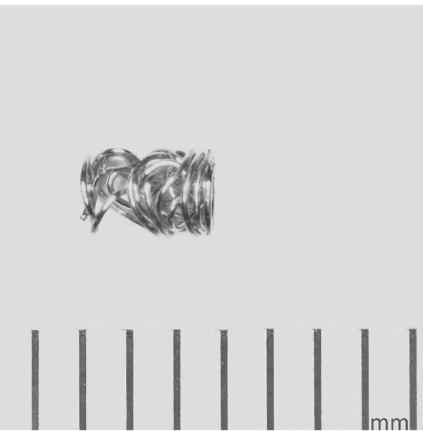
Figure 1: The metallic tissue marker (Achieve Marker, 3-mm length, CareFusion, Vernon Hills, IL) that underwent testing for MRI issues at 3 Tesla. Note the irregular surface, allowing for growth of tissue in and around this implant to reduce migration once it is